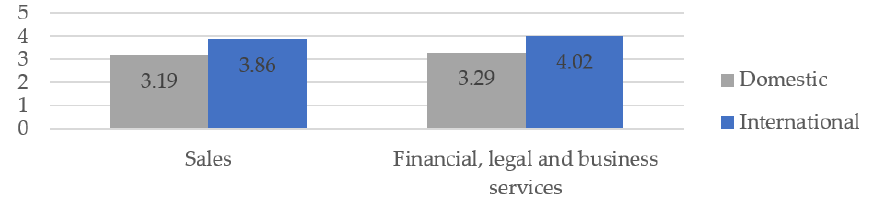
Figure 5. Sales and financial, legal and business services’ level of attitude at international and domestic companies.